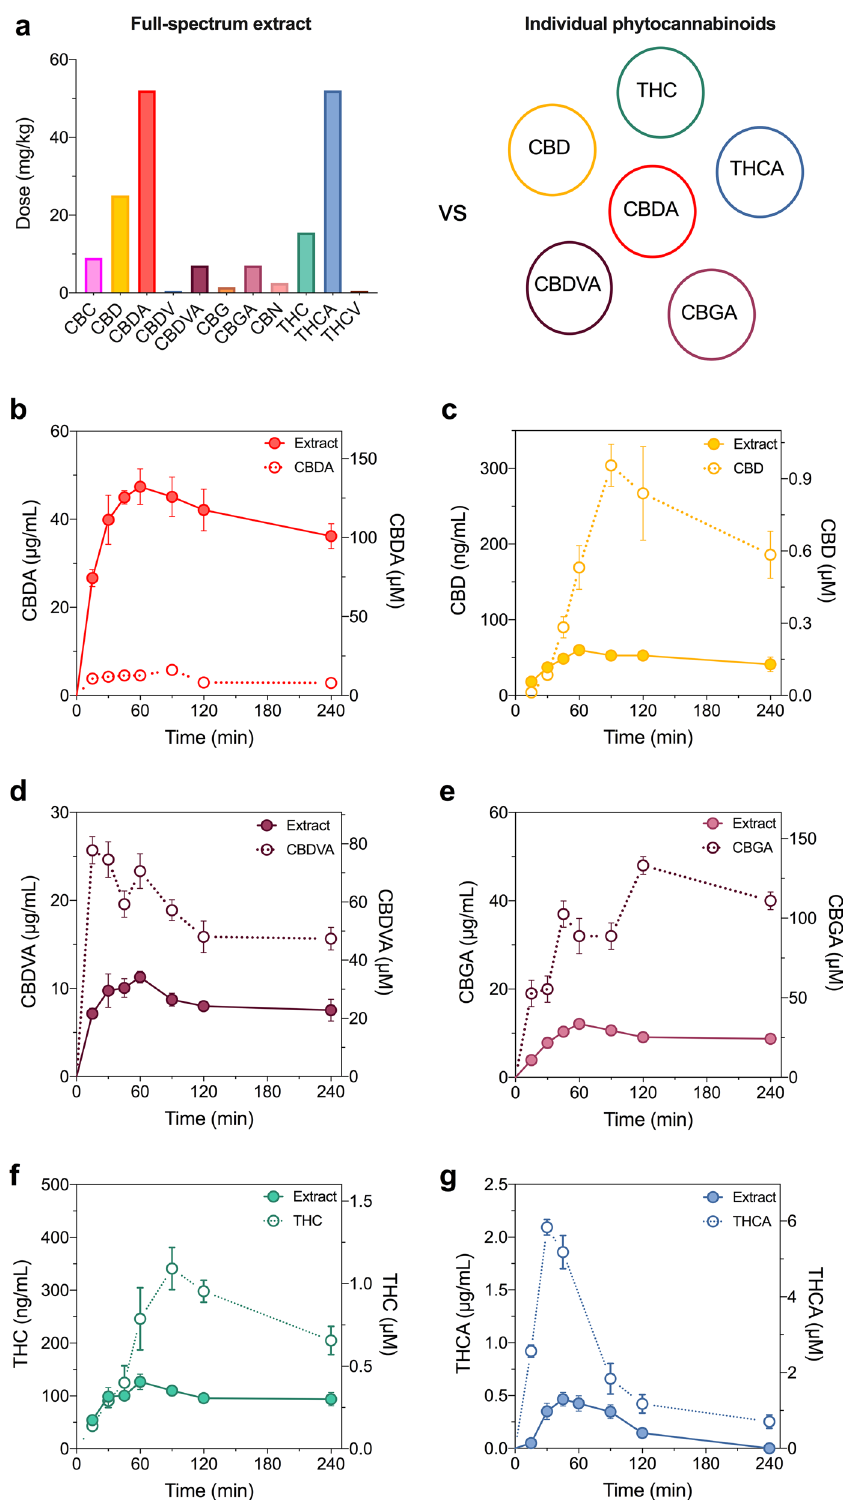
Figure 1. Pharmacokinetic analysis of orally administered cannabinoids in mouse plasma. Cannabinoids were administered orally as either a full-spectrum cannabis extract or individually at equivalent doses to those in the full-spectrum extract. ( a ) Dose and profile of cannabinoids within the full-spectrum extract (left panel) vs. the cannabinoids administered individually (right panel). Concentration–time curves for ( b ) CBDA, ( c ) CBD ( d ) CBDVA ( e ) CBGA ( f ) Δ 9 -THC and ( f ) Δ 9 -THCA. Concentrations are depicted as both mass concentrations (left y-axis) and molar concentrations (right y-axis) for each cannabinoid administered as a full-spectrum extract (solid symbols) or as an individual compound (open symbols). Data are expressed as means ± SEM, with n = 4–5 per time